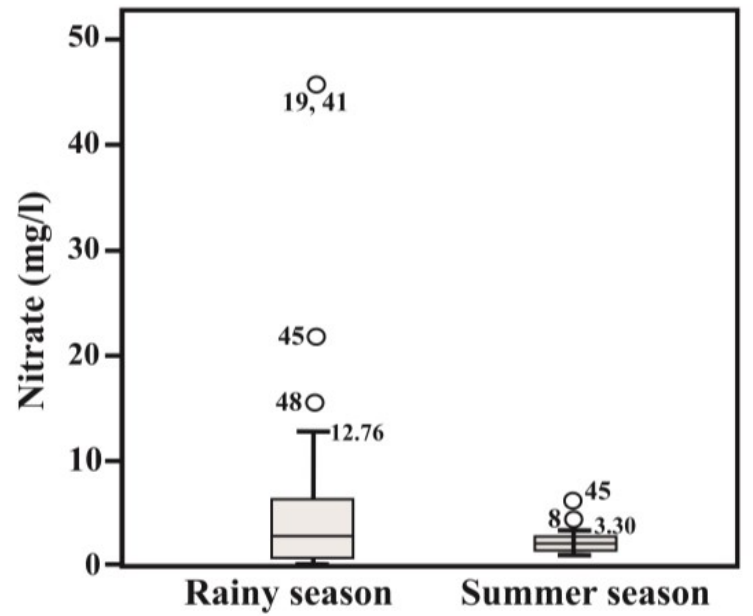
Figure 10. Box plot showing NO 3 − concentrations at 90 percentile in both